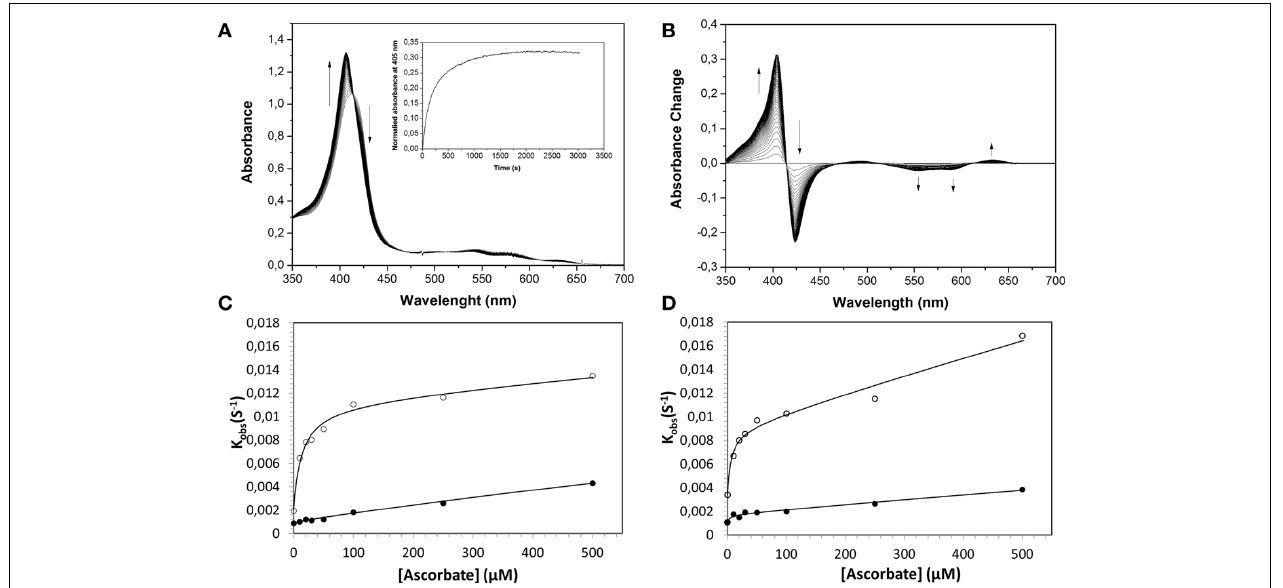
FIGURE 3 | Reduction of ferrylHb by ascorbate, illustrating the influence of increasing ascorbate concentrations on the reaction rate constants. Ferryl HbF (10 μ M) was generated by adding hydrogen peroxide to ferric Hb at pH 7.4. Catalase was then supplemented to remove the excess of hydrogen peroxide and ascorbate was added to a final concentration of 100 μ M. (A) Represents the absorption spectra monitored every 15s over 25min. Inset :